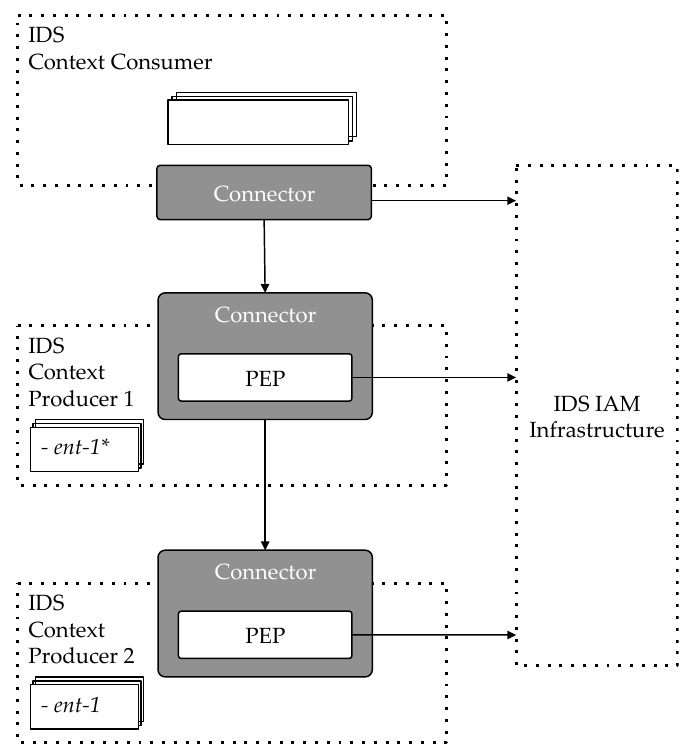
Figure 4. Trust between Context